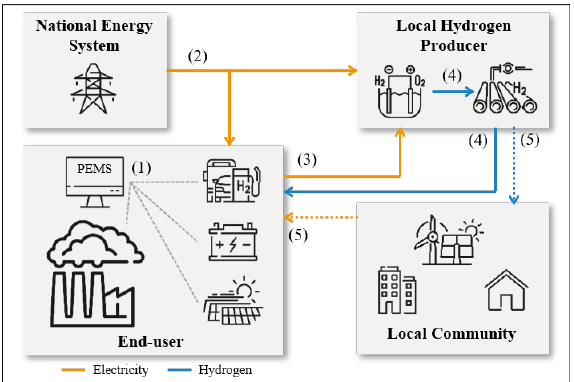
Figure 4. Proposed energy concept; solid lines represent considered interactions; dashed lines represent additional